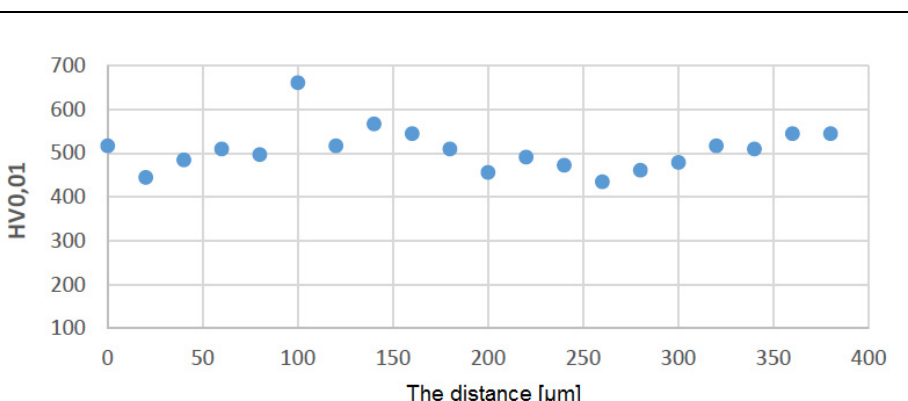
Figure 10. Distribution of microhardness on the leading edge for the protective coating made using the APS method.